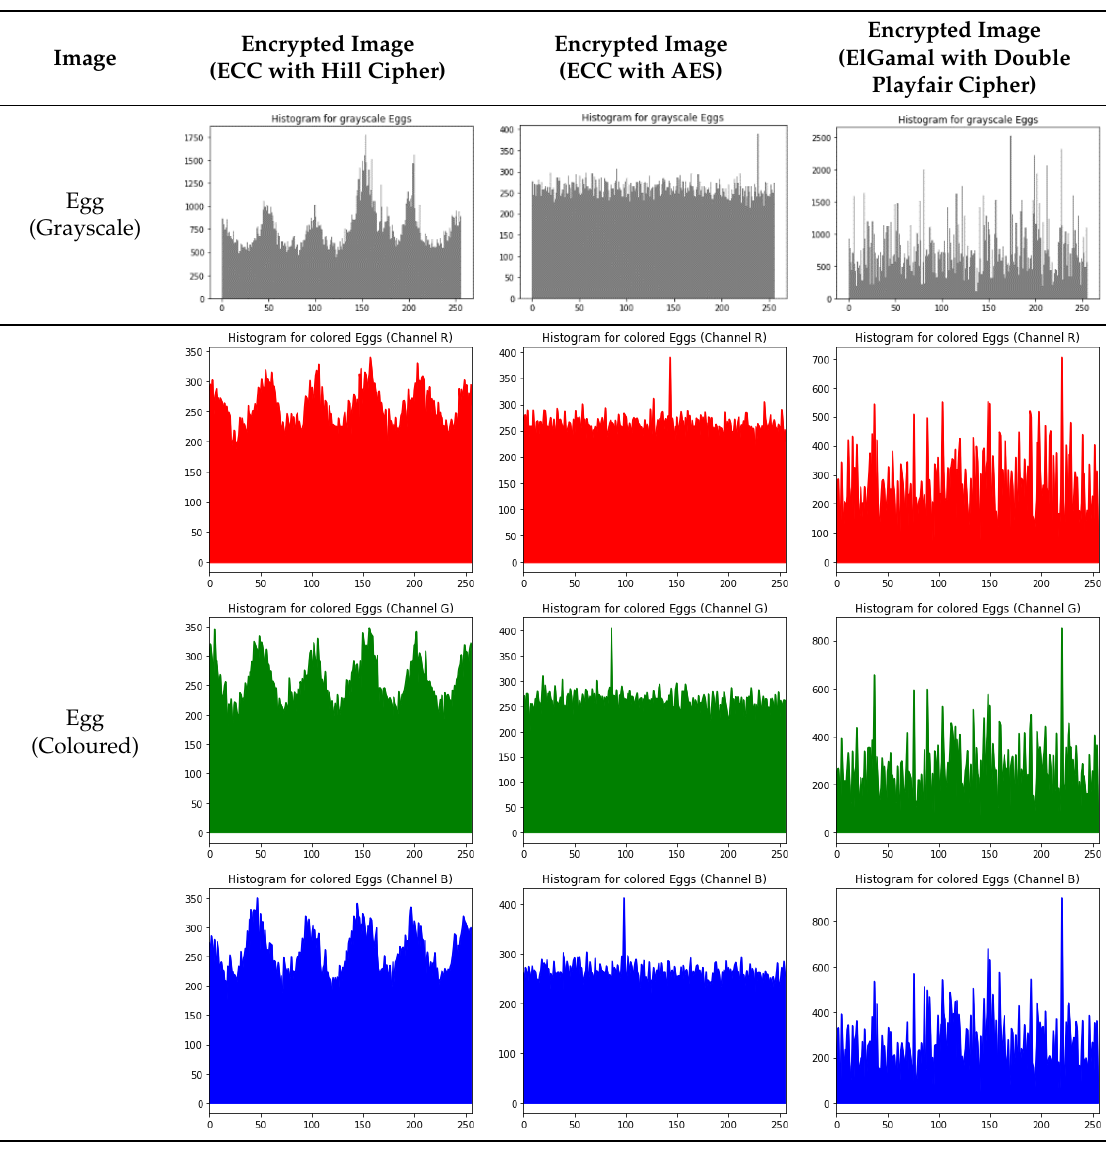
Table 7. Histogram analysis for encrypted image (Egg) using hybrid